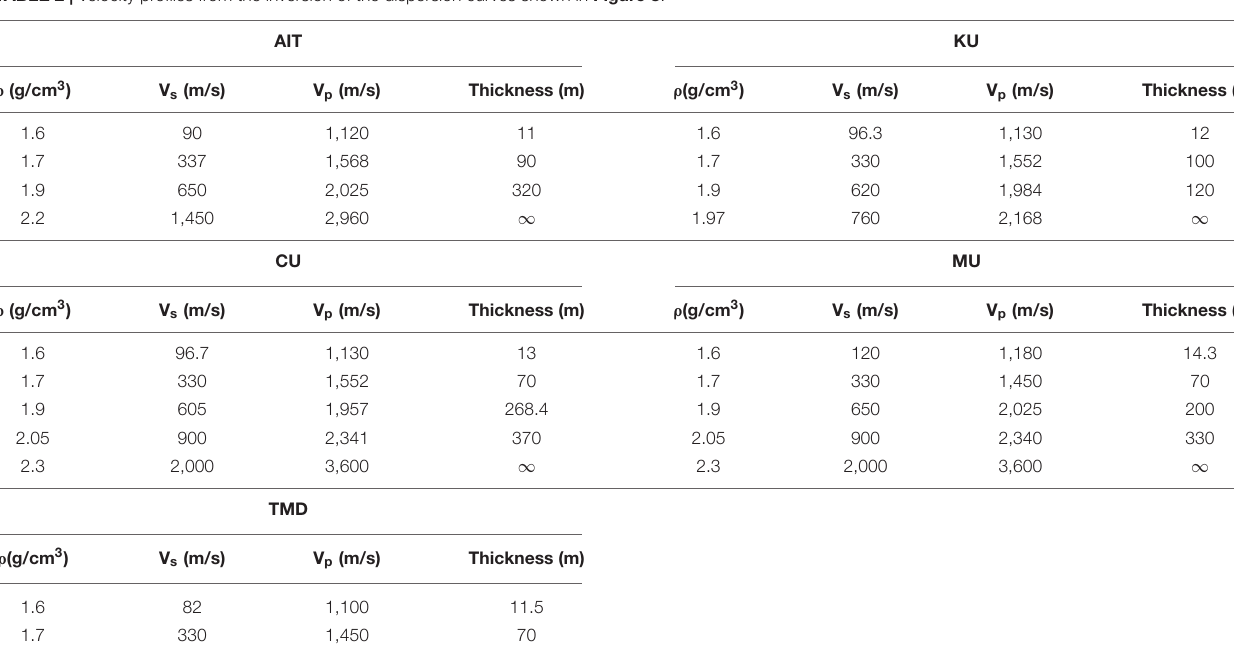
TABLE 2 | Velocity profiles from the inversion of the dispersion curves shown in Figure 8